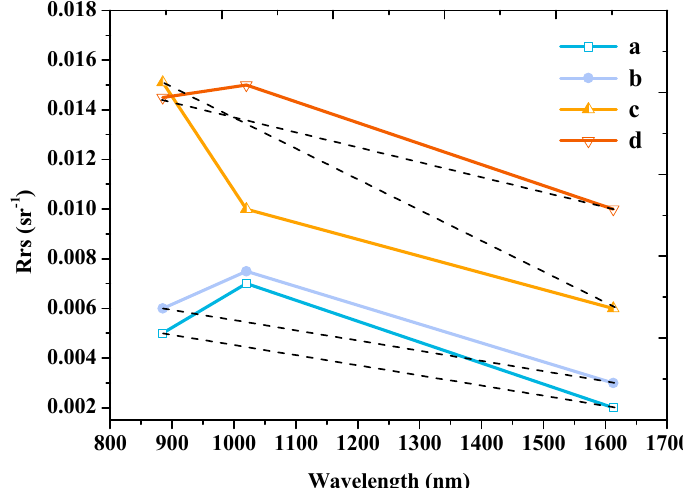
Figure 13. Four typical water spectra at 885, 1020, and 1613 nm: a and b denote the clean water in the lake center and nearshore regions, while c and d denote the turbid water in the lake center and the nearshore regions, respectively.